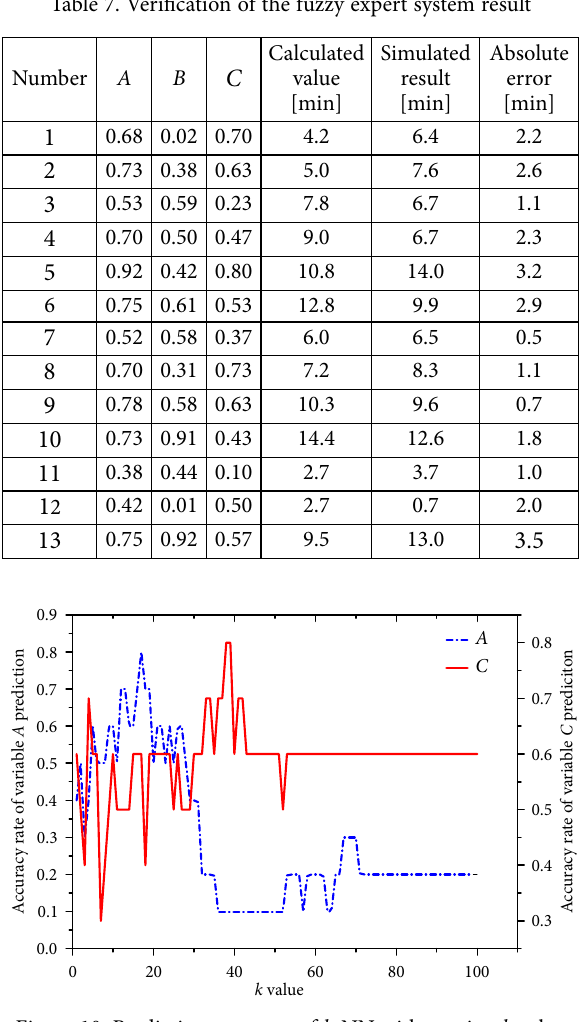
Figure 10. Prediction accuracy of k -NN with varying k